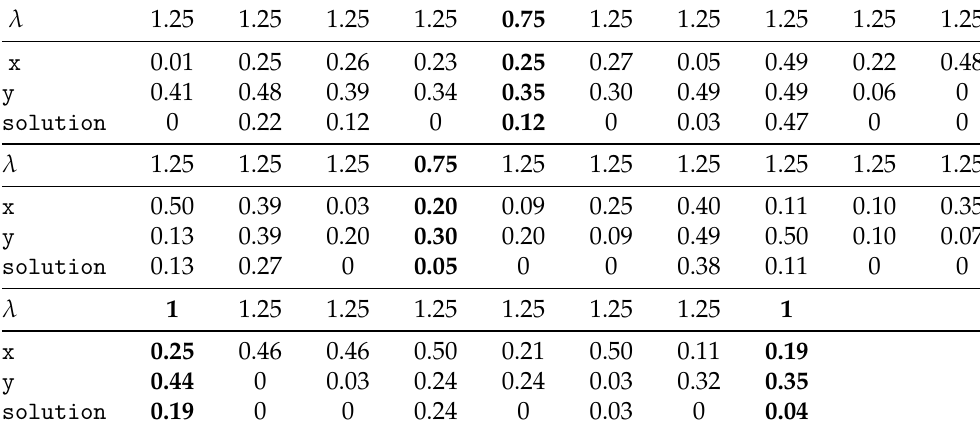
Table 1. Data for parameter learning of the conjunctive function for the class no . λ